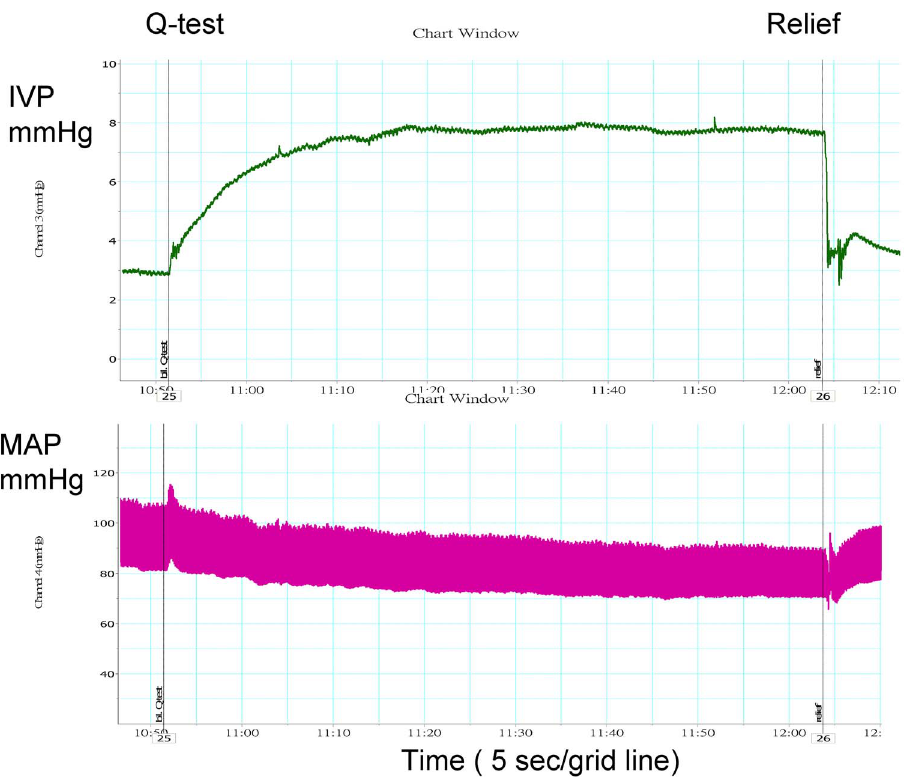
Figure 1. Changes in the intraventricular pressure (IVP) and mean arterial pressure (MAP) of SD rats due to Queckenstedt’s test (Q- test).